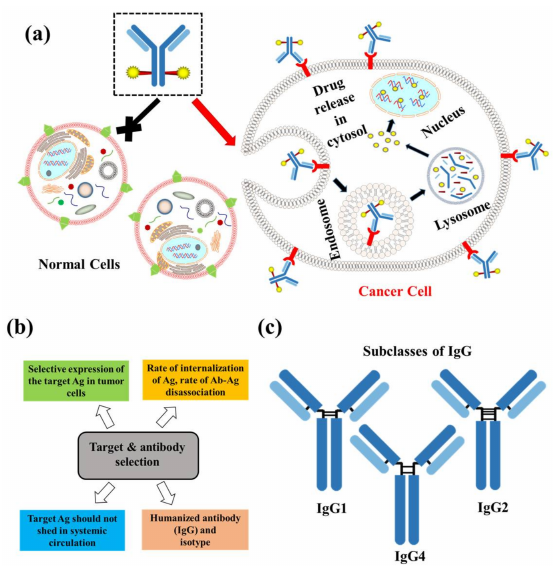
Figure 2. ( a ) Schematic representation of ADC uptake in cells expressing target antigen followed by release of the payload; ( b ) Key considerations while choosing target and antibody isotype for ADC developments; and ( c ) subclasses of